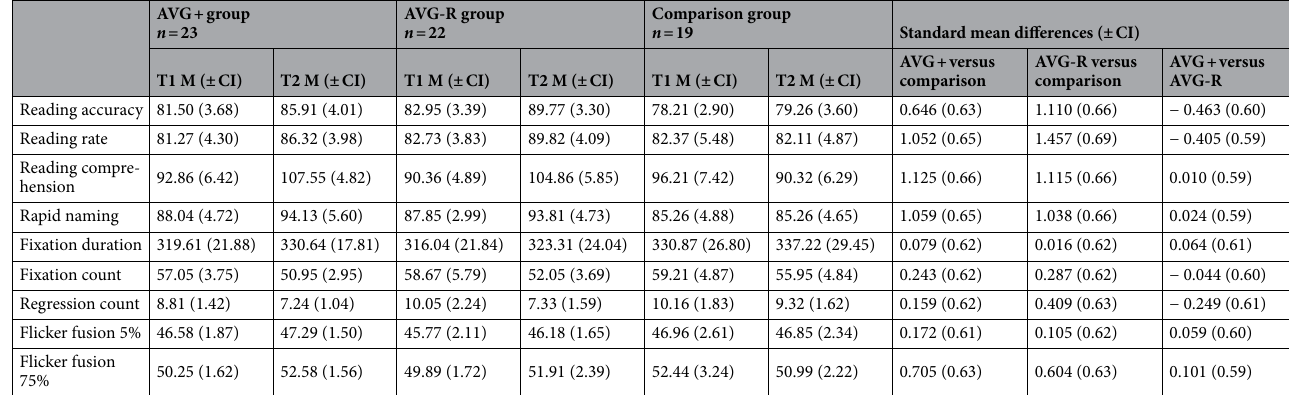
Table 2. Averages, 95% confidence intervals and standard mean differences of outcome measures for each group and timepoint. AVG-R = Action Video Game-Regular Group; AVG+ = Increased Attention Action Video Game Group; ± CI = + / − 95% Confidence Interval; Standard Mean Differences are interpreted as small = 0.2, moderate = 0.5 and large = 0.8, with positive scores in favour of the first group listed in the comparison.